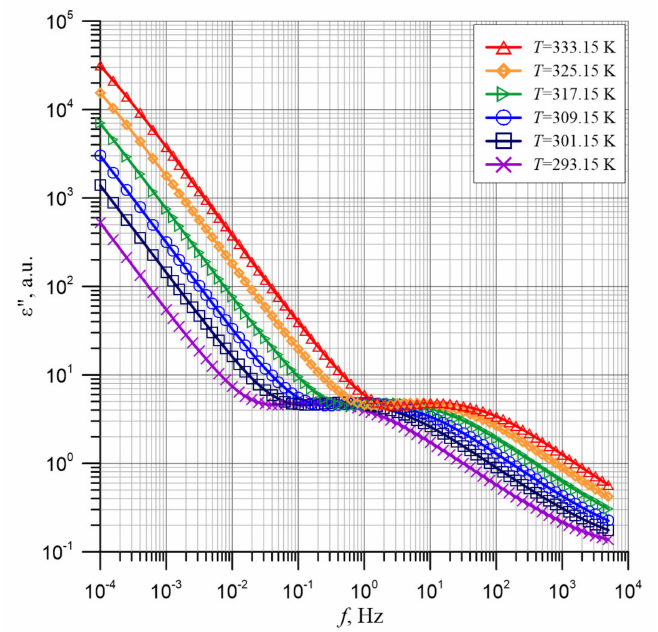
Figure 9. Frequency dependence of imaginary permittivity component of the composite of pressboard, mineral oil and water nanoparticles for temperatures from 293.15 to 333.15 K. Points—experimental results, continuous lines—approximation